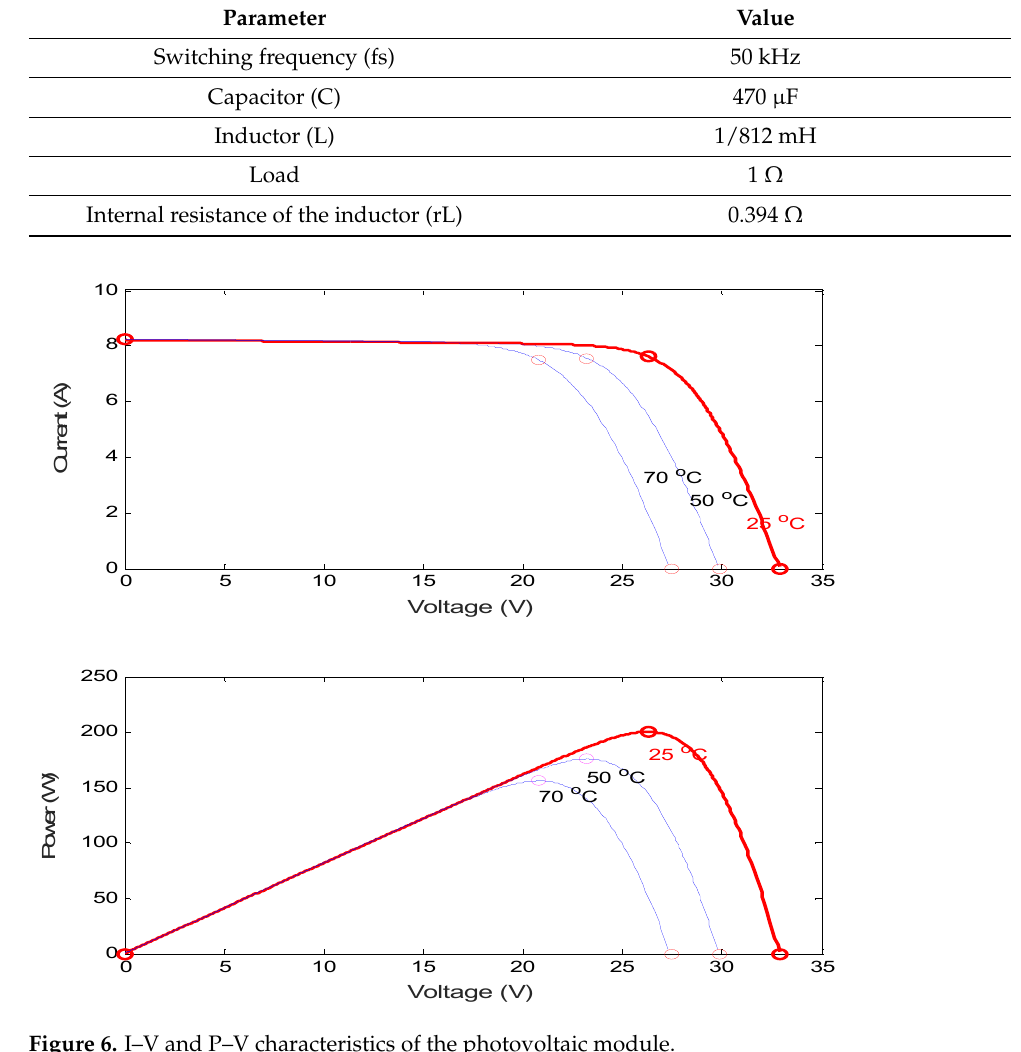
Figure 6. I–V and P–V characteristics of the photovoltaic module.